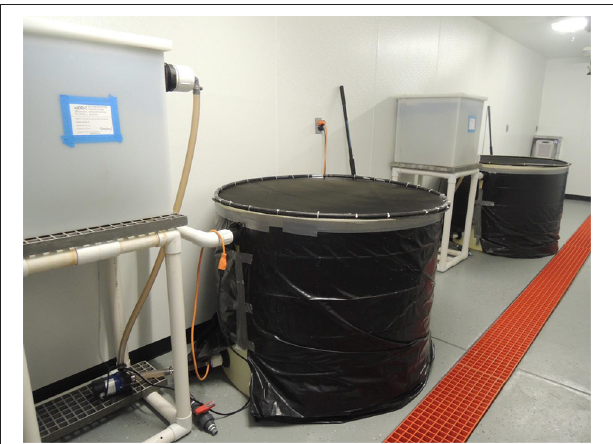
FIGURE 1 | Picture of experimental aquaculture system for the Vibrio spp. challenging trial. Seawater stream circulated through the square water quality controller contained solids filter and covered biofiltration sump with bio-ball media, the circular fish culture tank, seawater pump, and again the controller. Four experimental groups (control, group2, group3, and group4) were allocated to four identical and separate experimental